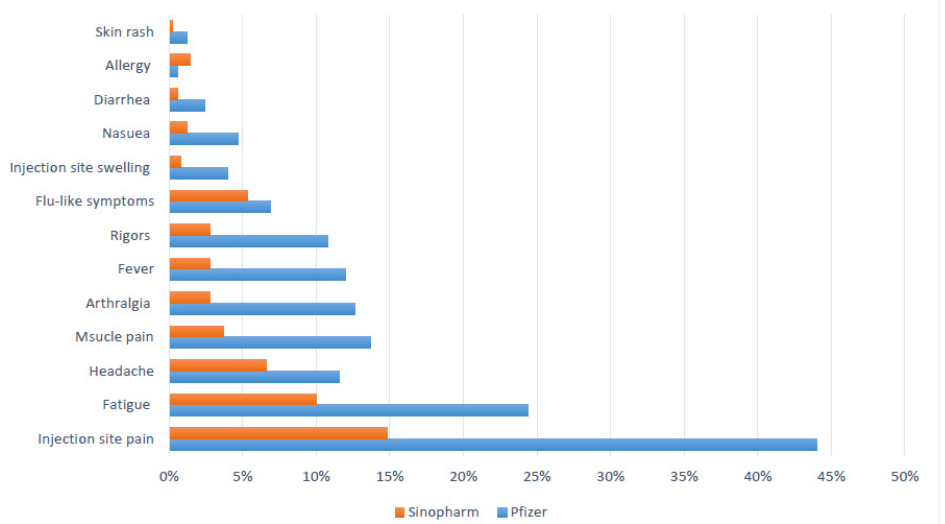
Figure 4. The frequency of adverse reactions after the second dose of the COVID 19 vaccine.